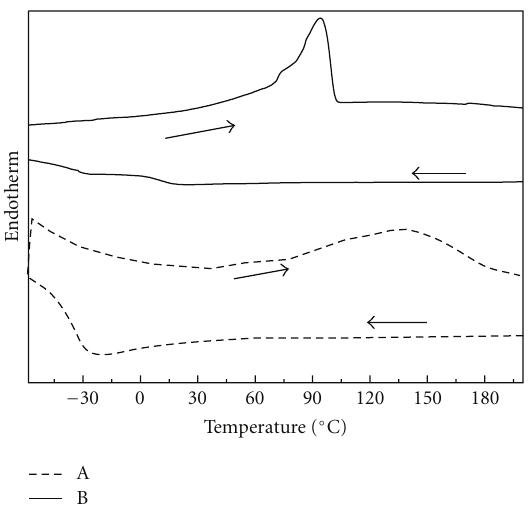
Figure 3: Di ff erential scanning calorimeter curves of (A) HEEDAI and (B) HEPI.